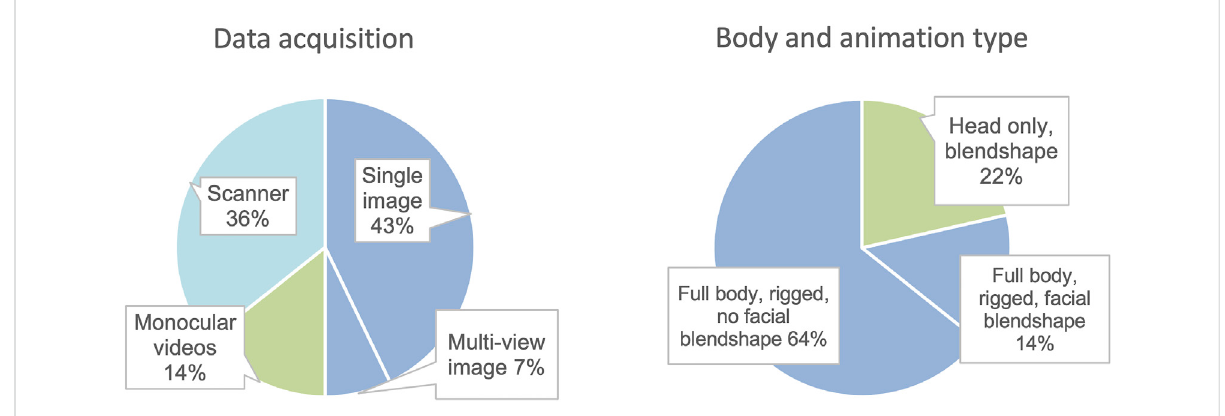
FIGURE 6 Different data acquisition methods and body and animation types of digital body generation pipelines, illustrated as bar charts.